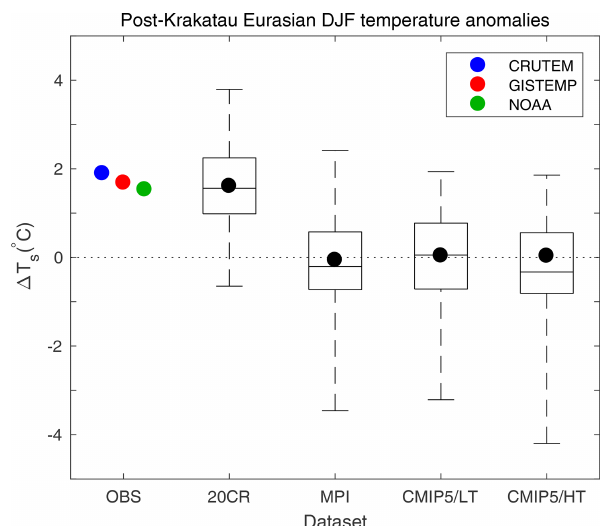
Figure 8. Eurasian surface temperature anomalies in the first post- Krakatau DJF season. The colored dots show the observed values from the CRUTEM, GISTEMP, and NOAA datasets (for the latter two, a shorter three-winter reference period was used, owing to data availability). The box plots show the model values, with the me- dian as well as the 25th and 75th percentiles in each dataset, the whiskers indicating the spread of the ensembles for each dataset, and the black dots indicating the mean of each ensemble. For 20CR, a 56-member ensemble was analyzed; for the MPI model, a 100- member ensemble was analyzed; for the CMIP5 low-top (LT) mod- els, 68 simulations from 21 LT models were analyzed, and for the high-top (HT) models, 62 simulations from 19 HT models were an- alyzed. See Table 1 for the list of CMIP5 HT and LT models as well as the respective